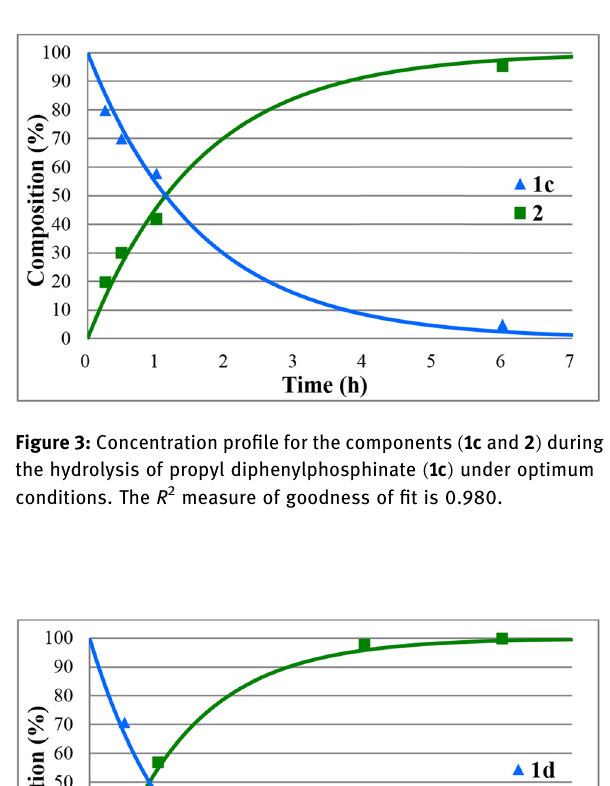
Figure 1: Concentration pro fi le for the components ( 1a and 2 ) during the hydrolysis of methyl diphenylphosphinate ( 1a ) under optimum conditions. The R 2 measure of goodness of fi t is 0.941.